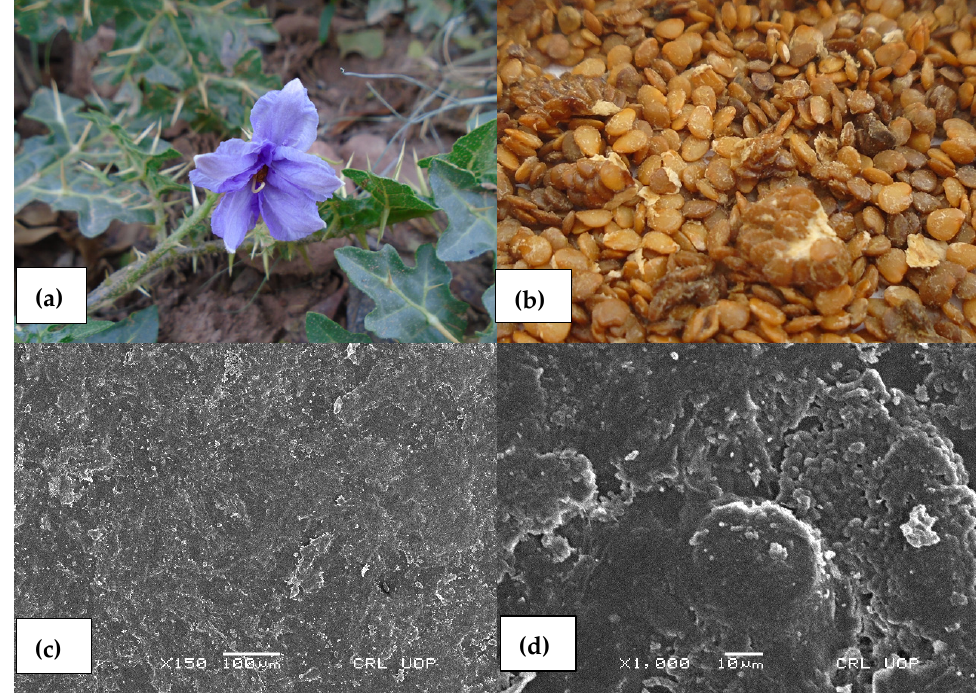
Figure 6. Solanum surattense ( a ) plant, ( b ) seeds, and ( c , d ) SEM micrograph of seed sculpturing.